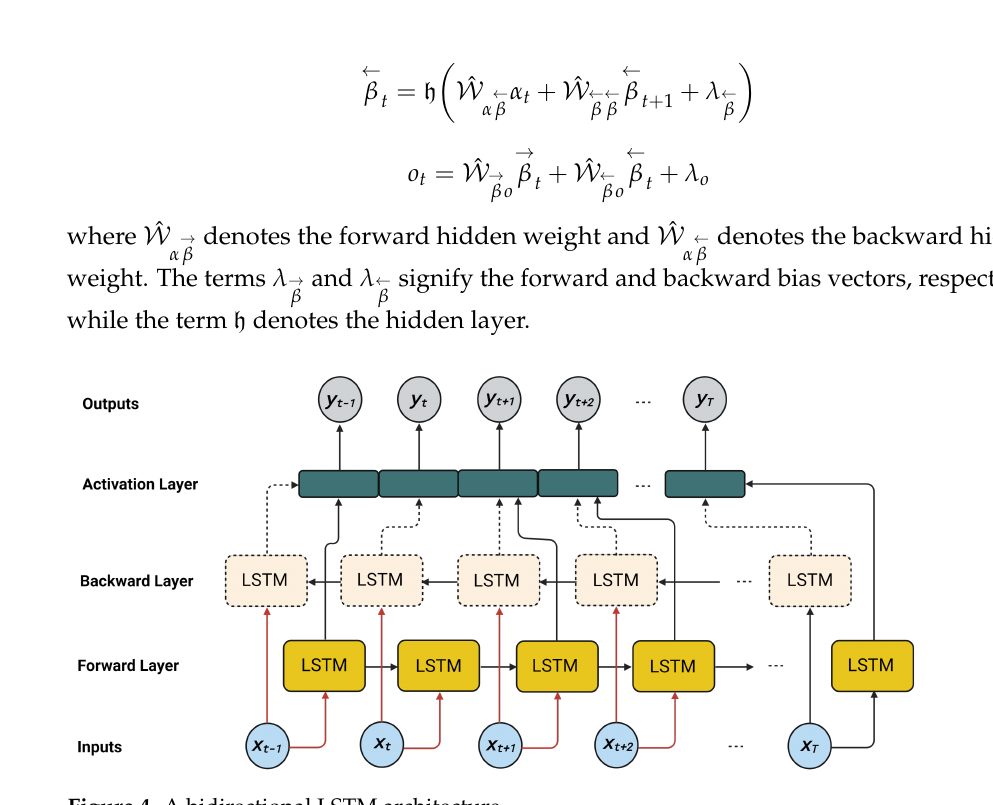
Figure 4. A bidirectional LSTM